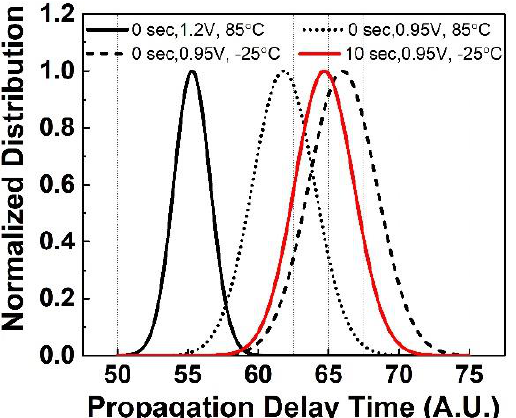
Figure 6. Normalized median and distributions plot of the propagation delay time with different temperatures, voltages, and processing times.